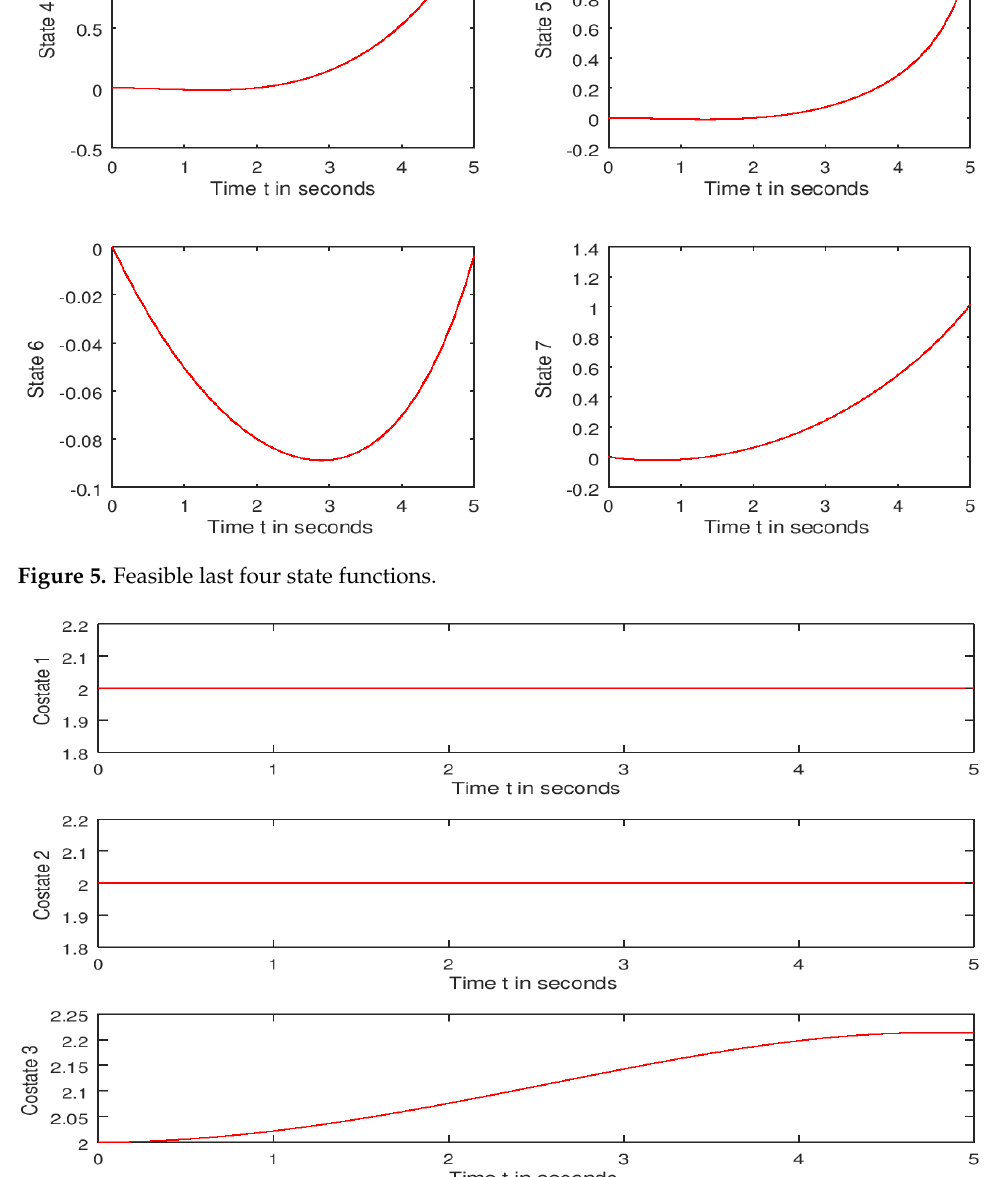
Figure 6. Feasible first three costate functions.